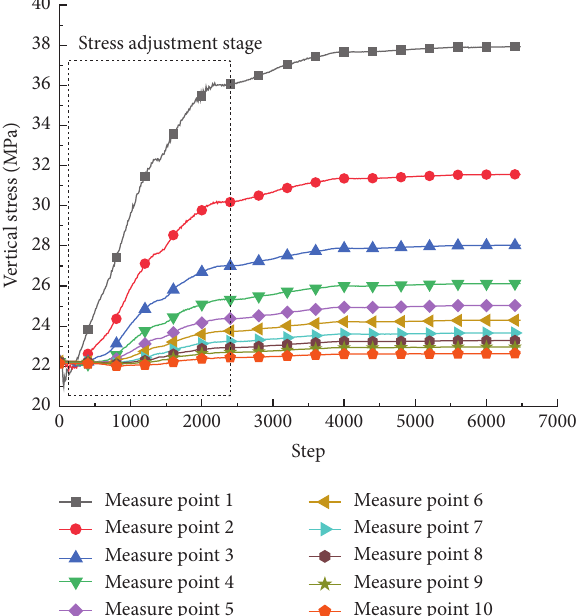
Figure 7: Vertical stress in leading area of working face.